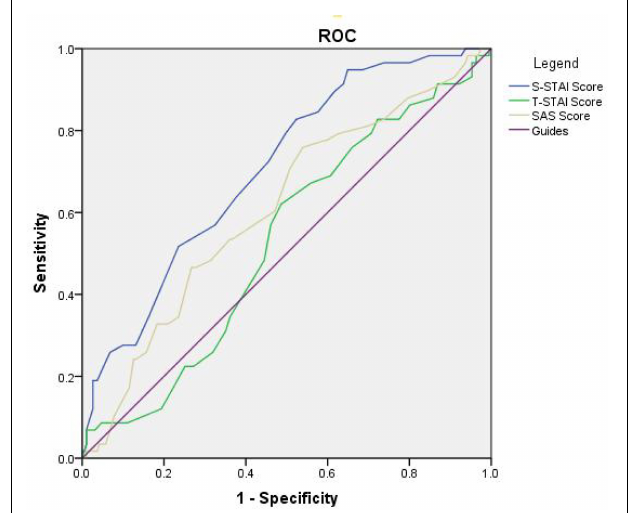
FIGURE 2 | Receiver operating characteristic (ROC) curve of the final logistic regression model of three anxiety scores associated with hypoxia. The curve is expressed as a solid line. AUC, area under the curve; ROC, receiver operating